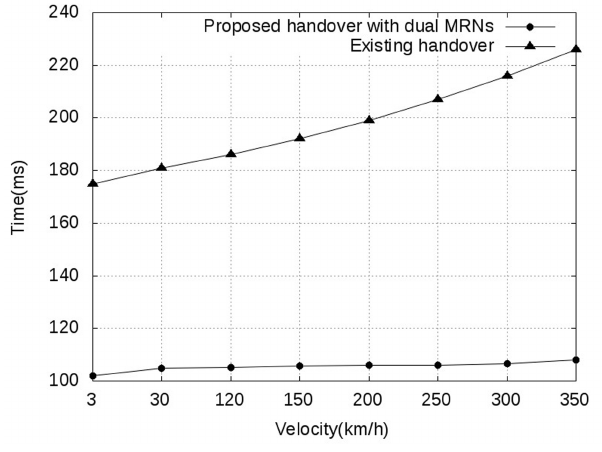
Figure 4. Average HO delay.